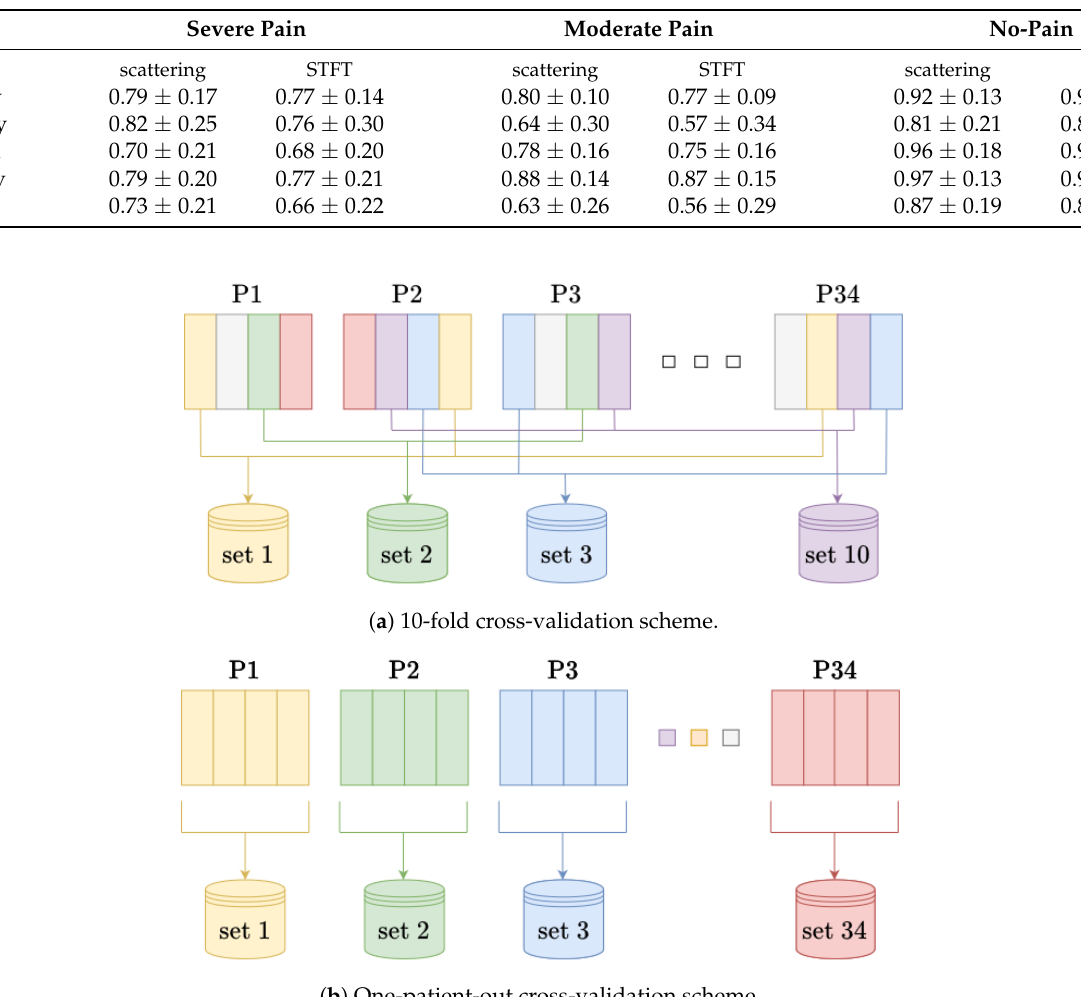
Table 6. Multiclass evaluation results of one-patient-out cross-validation (AdaBoost): comparison of STFT features and wavelet scattering features approaches.